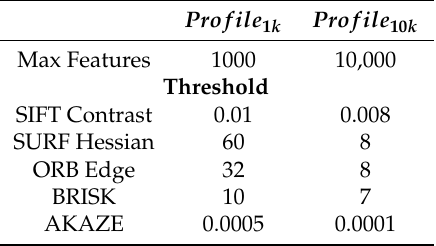
Table 2. Profile parameters